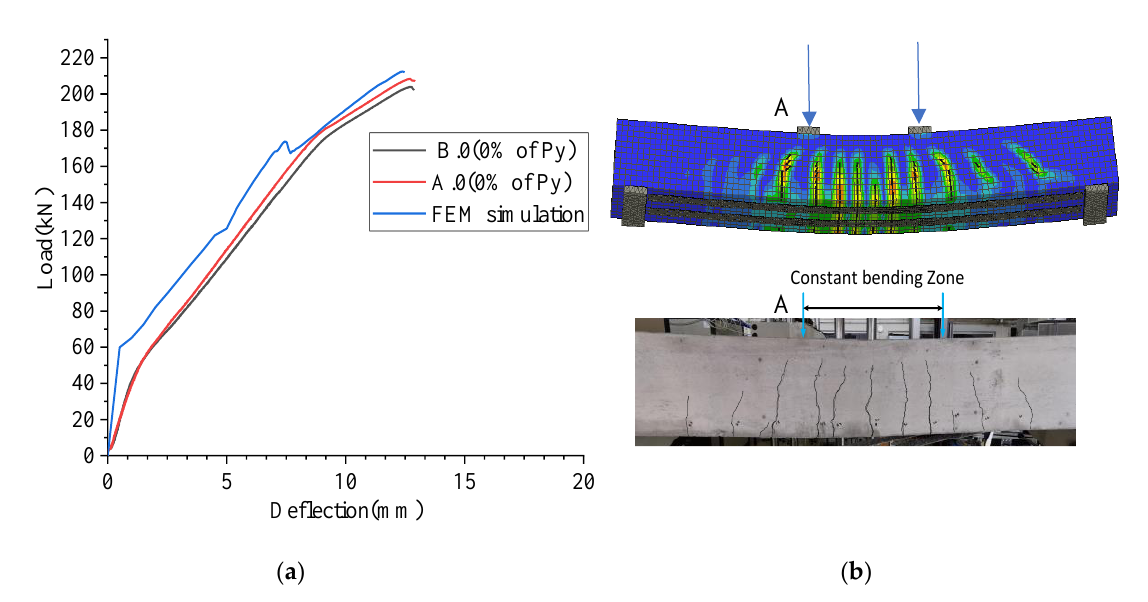
Figure 16. ( a ) Load vs. deflection ( b ) crack formation at 212 kN load during FEM simulation and cracks formed in B.0 beam.